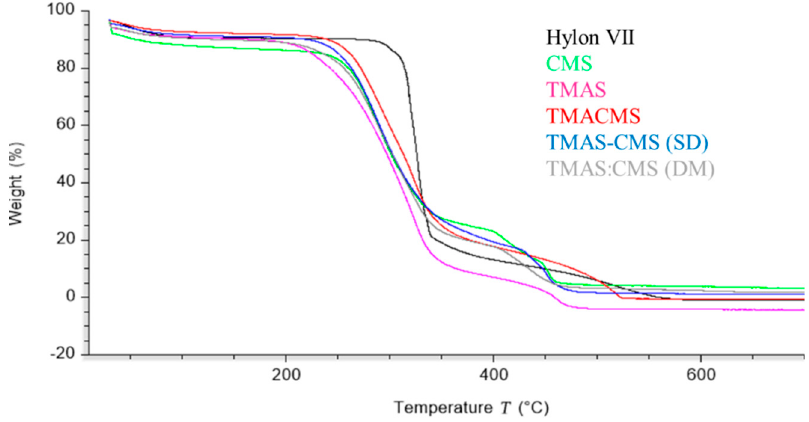
Figure 3. Thermogravimetric patterns of Hylon VII, CMS, TMAS, TMACMS, TMAS-CMS (SD), and TMAS:CMS (DM).